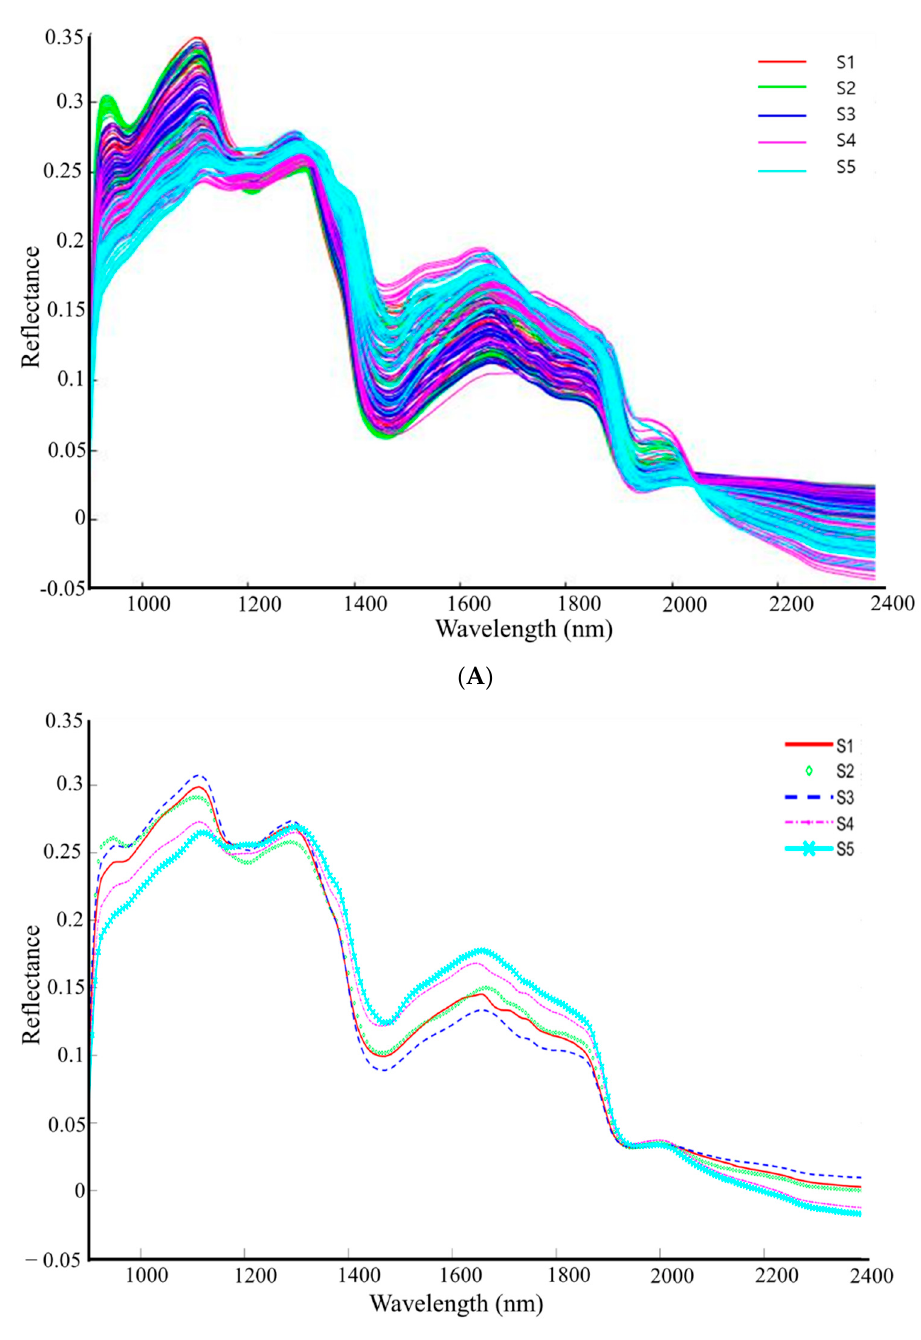
Figure 5. MSC preprocessed spectra ( A ) and mean spectra ( B ) of TMR feed and by-product samples (n = 200) for moisture content prediction (S1: TMR; S2: mixed by-products; S3: palm kernel expeller; S4: almond pie; S5: corn bran).